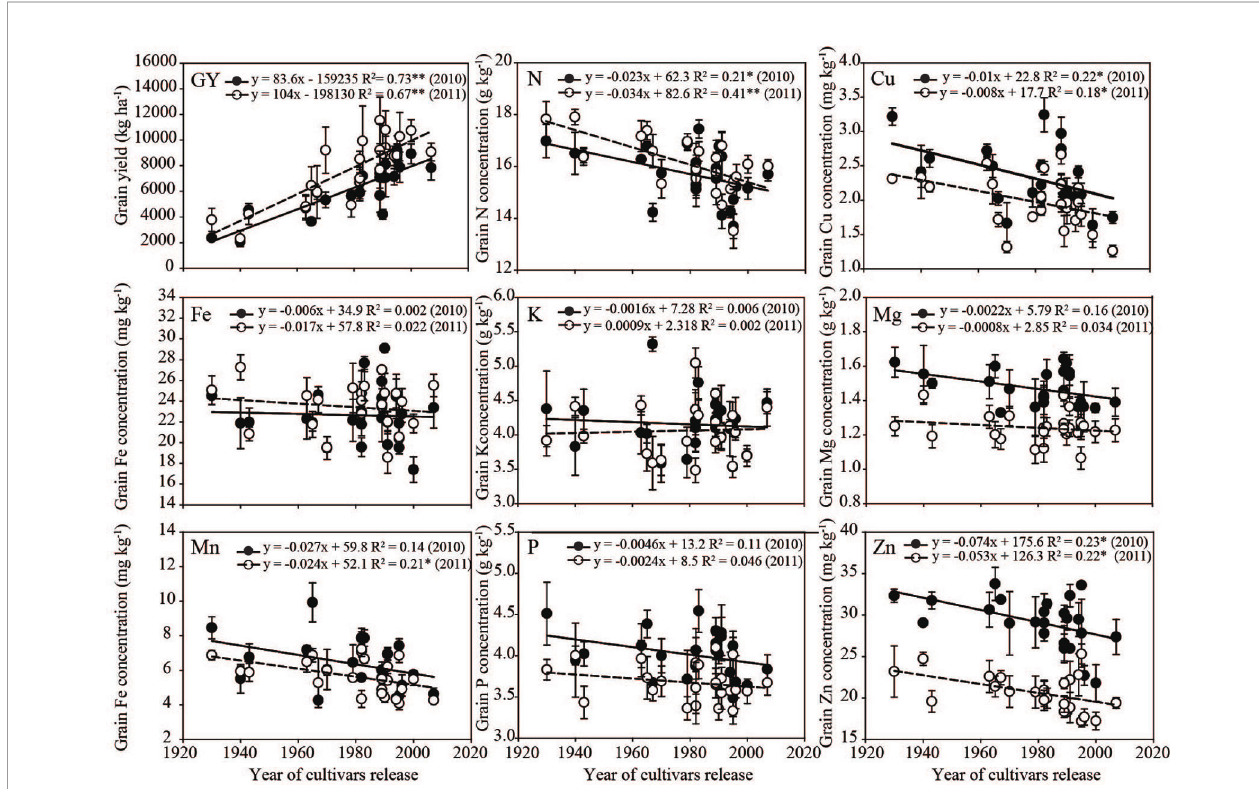
FIGURE 1 | Relationship between the year of cultivars release, grain yield, and grain nutrient (N, Cu, Fe, K, Mg, Mn, P, and Zn) concentrations. Data were collected in Shun-Yi (SY). Closed and open circle denote the mean ± SD of three and four replicates in 2010 and 2011, respectively. *, ** denote signi fi cance at the 0.05 and 0.01 probability levels, respectively; NS, not signi fi cant (P >